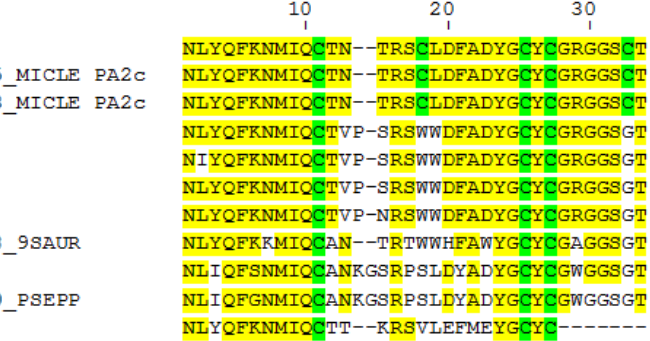
Figure 2. ( A ) The fraction that contains the Mlx-8 was purified on HPLC-RF using a C18 column eluted under a flow rate of 1 mL/min with solvents A and B from 0 to 100% acetonitrile in 0.1% TFA aqueous solution represented by the trace. The absorbance was read at 214 nm. Only the highest peak was collected, thus removing the contaminants from the sample and guaranteeing its purity. ( B ) Mass spectrum of the Mlx-8 toxin obtained via mass spectrometry technique in MALDI-TOF ionization mode. The toxin was analyzed using the saturated sinapinic acid matrix solution (1:1 v/v) and deposited directly onto MCP AnchorChip 600/384 plates. This was co-crystallized at room temperature. After ionization, the Mlx-8 toxin molecules were transformed into ions and counted by the detector as a function of their mass/charge (m/z) and their molecular mass was identified.